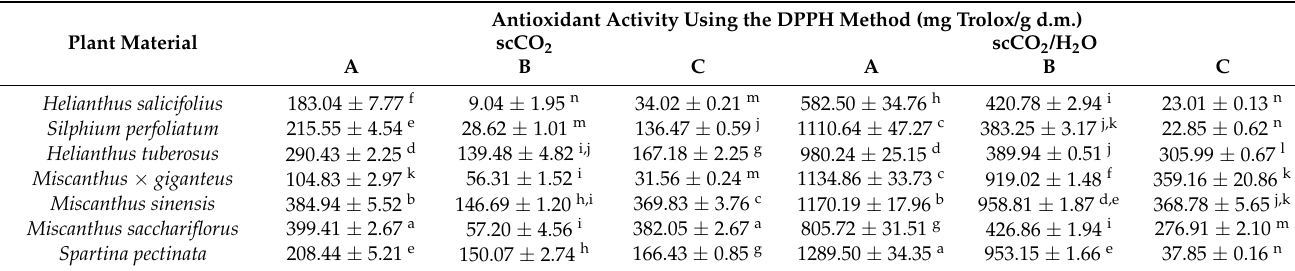
Table 3. Influence of extraction conditions (scCO 2 or scCO 2 /H 2 O) and harvest time ((A) June, (B) October and (C) February) on antioxidant activity (DPPH assay)* in extracts from herbaceous